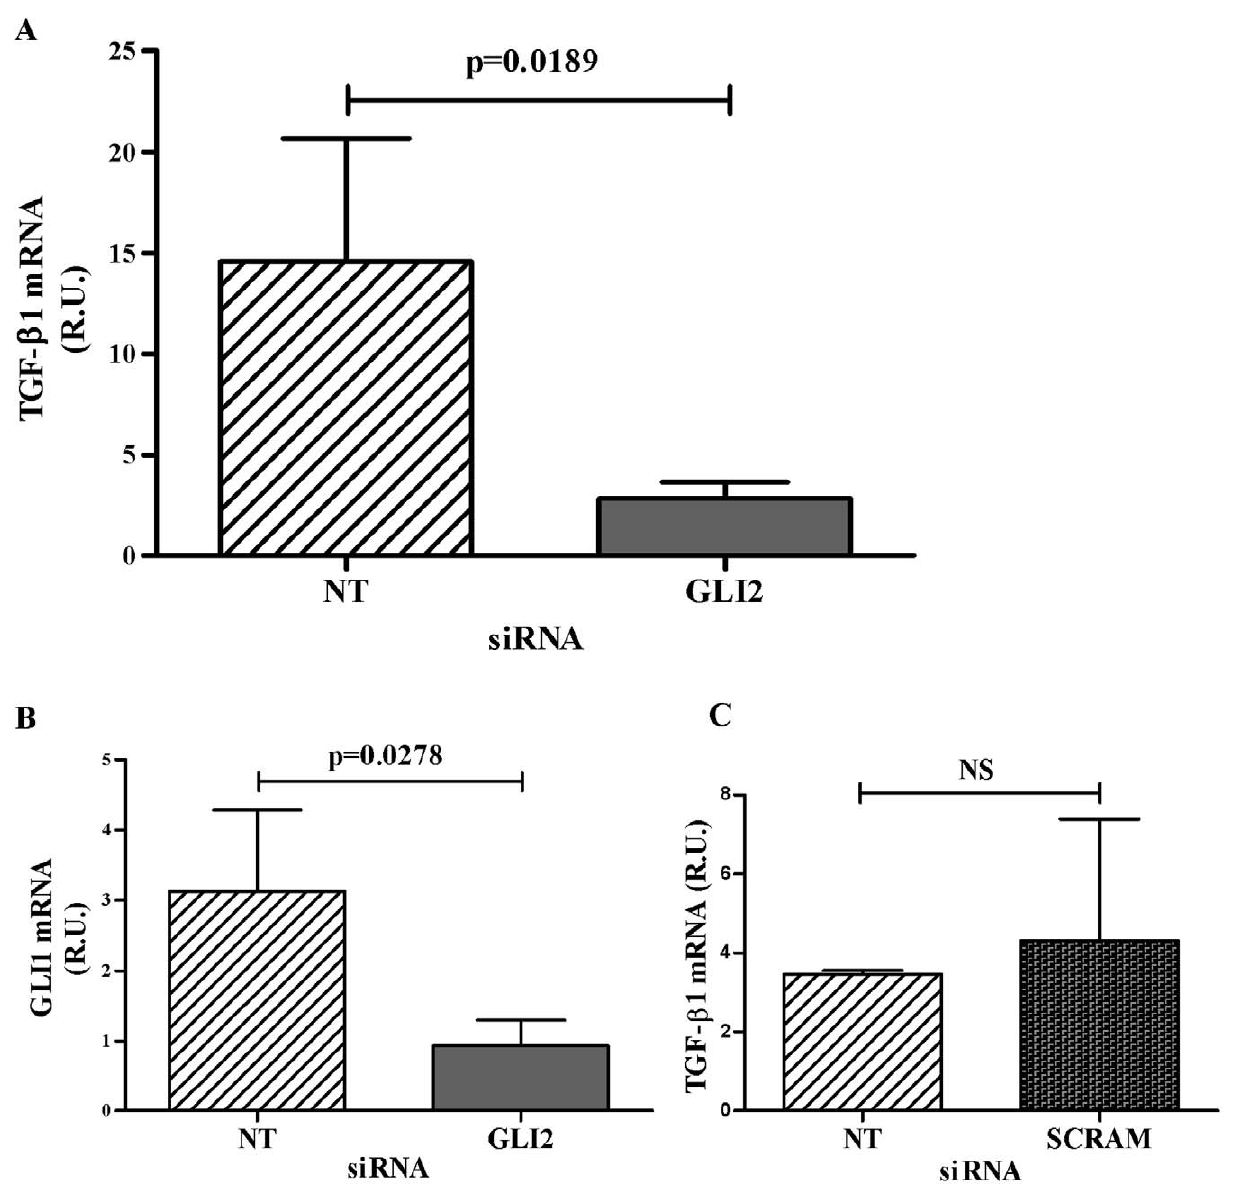
Figure 4. GLI2 Knockdown in CD4 + CD25 + FoxP3 + Treg Decreases Levels of TGF- b 1 mRNA. CD4 + CD25 + FoxP3 + Treg were enriched from PBMC and then incubated for 72 hours with non-targeting (NT) or GLI2 siRNA. The cells were then stimulated (1 a CD3/ a CD28 bead: 1 cell) for an additional 24 hours. RT-PCR was used to measure TGF- b 1 mRNA levels. Relative TGF- b 1 or GLI1 mRNA was normalized to 18S rRNA. (A) GLI2 knockdown in Treg significantly decreased TGF- b 1 transcription (n=7, * p=0.0189). (B) GLI1 mRNA was also measured as a control GLI2-regulated gene; showing that knockdown of GLI2 in Treg also diminished GLI1 mRNA (n=5, ** p=0.0278). (C) The sequence of the GLI2 siRNA was scrambled (SCRAM) as an additional GLI2 siRNA negative control and was not significantly different from the non-targeting